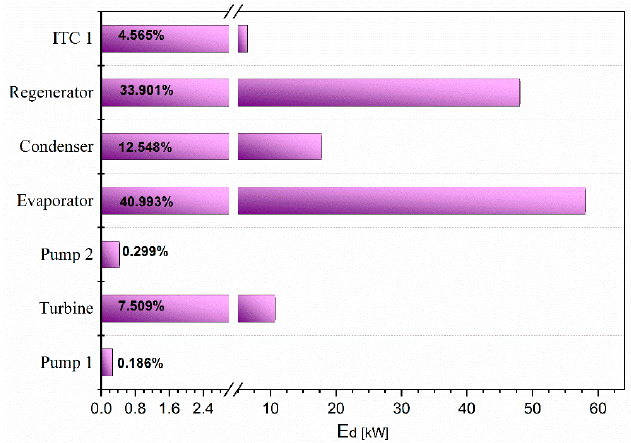
Figure 5. Exergy destroyed fraction in each RORC system component.